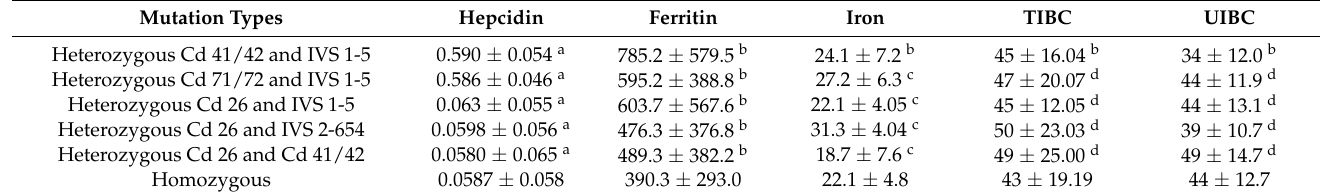
Table 9. Biochemical characteristics according to type of mutation found in parents (mother and/or